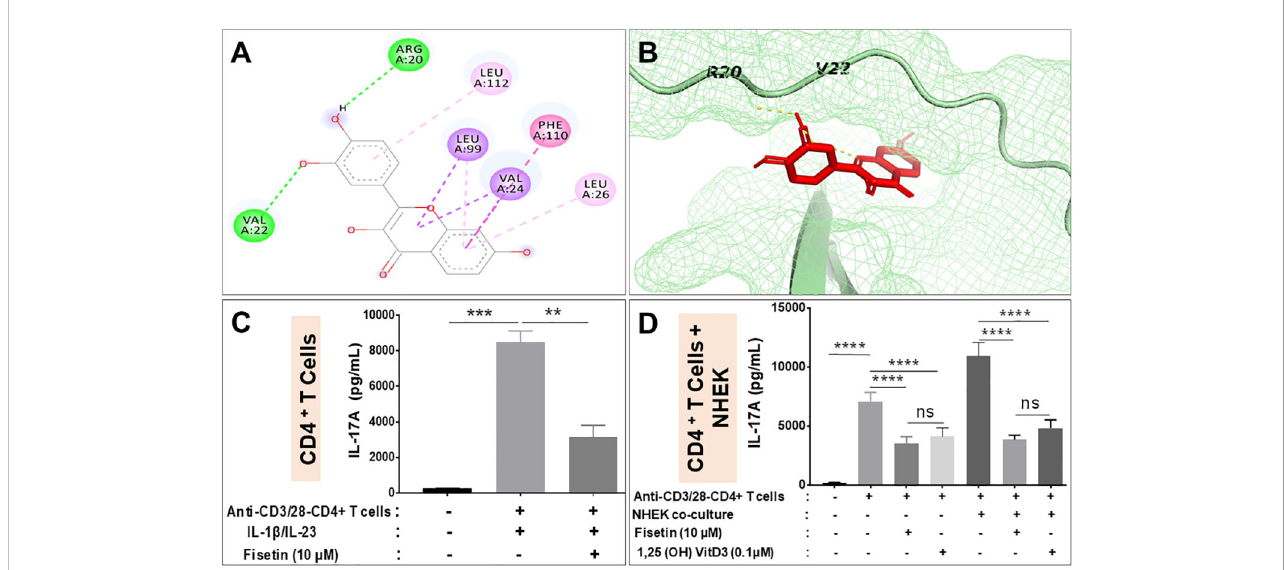
FIGURE 4 Fisetin reduces IL-17A production by activated CD4 + T lymphocyte alone and when co-cultured with keratinocytes in vitro. (A) Binding af fi nity of fi setin to IL-17A, predicted using Autodock vina and interaction of fi setin in binding pocket of IL-17A shown in stick and mesh model. (B) This interaction involves hydrophilic and hydrophobic interactions with different residues shown in 2D layout. ELISA assay for the levels of IL-17A secretion by anti-CD3/ anti-CD28 activated puri fi ed human CD4+ T lymphocytes under different conditions: (C) anti-CD3/anti-CD28 activated CD4+ T lymphocytes cultured alone and then primed with IL-1 b and IL-23 to enhance IL-17A production in the presence or absence of fi setin. (D) anti-CD3/anti-CD28 activated CD4+ T lymphocytes co-cultured with NHEKs in the presence or absence of fi setin (10 µM) or Vit-D3 (0.1 µM). Cells were cultured for 48 h in the indicated conditions and secreted IL-17A in the condition culture media was assayed by ELISA. Bar represents Means ± SE resulted from at least three separate experiments and paired t test was used to compare values between treatments. **P <0.01 and ***P <0.001 ( – ). indicates non-activated or treated cells. ns, not signi fi